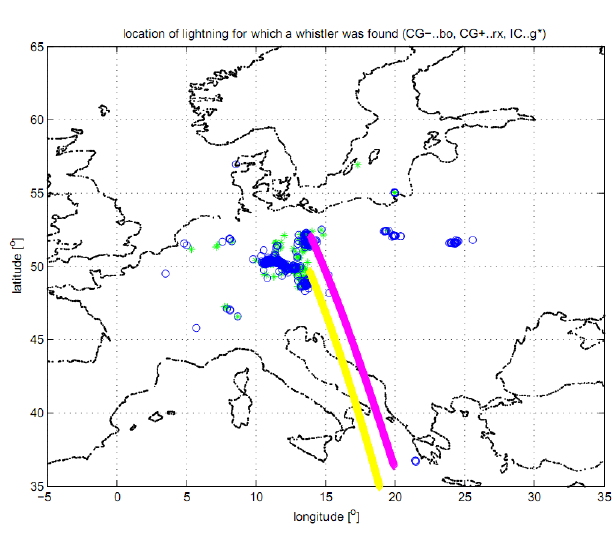
Fig. 3. An example of lightning activity during one pass of the satellite over the European region (evening pass on 29 July